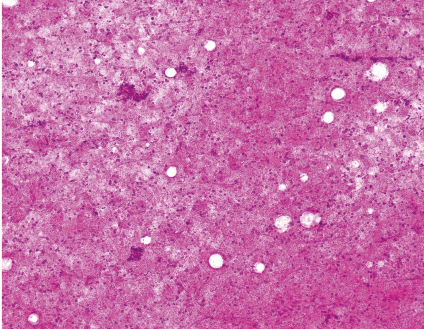
Figure 1: Initial MRCP showing pancreatic head mass with nonen- hancing areas in the center. Figure 2: Necrotic material on the needle aspiration smear (H&E